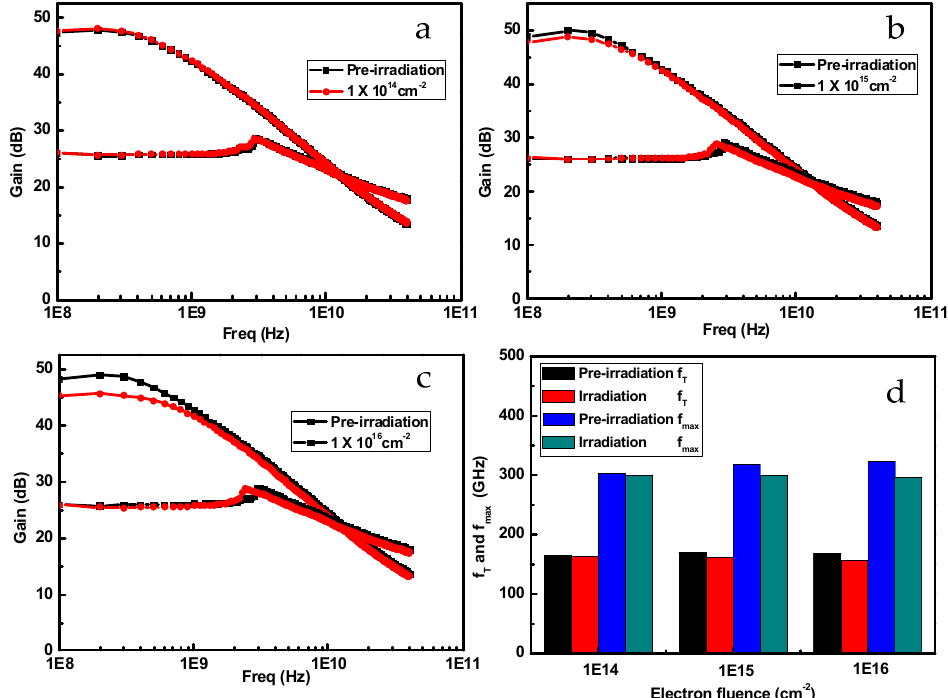
Figure 7. Frequency characteristics of InP-based HEMTs before and after 1 MeV electron irradiation with different irradiation fluences. ( a ) 1 × 10 14 cm − 2 , ( b ) 1 × 10 15 cm − 2 , ( c ) 1 × 10 16 cm − 2 , ( d ) variation of f T and f max with different electron fluences.